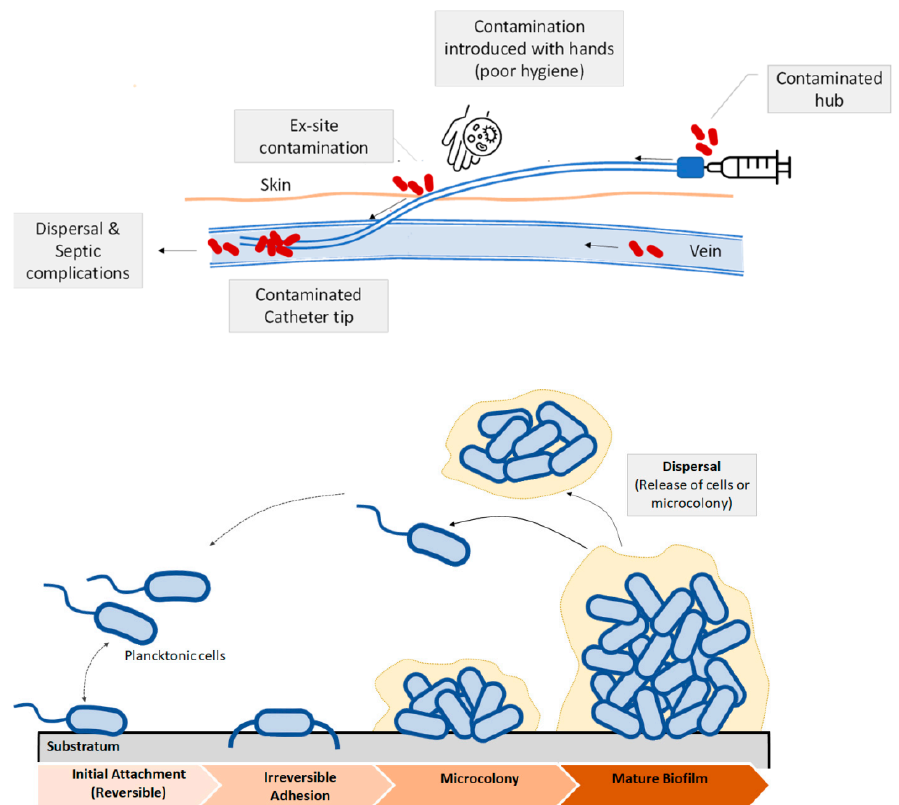
Figure 3. ( Top ) Schematic view of biofilm formation in different regions of a venous catheter. Microbial contamination may come from the catheter hub, the patient’s skin, due to the lack of skin antisepsis or from the bloodstream. ( Bottom ): Biofilm development and dispersal of bacteria or microcolonies.